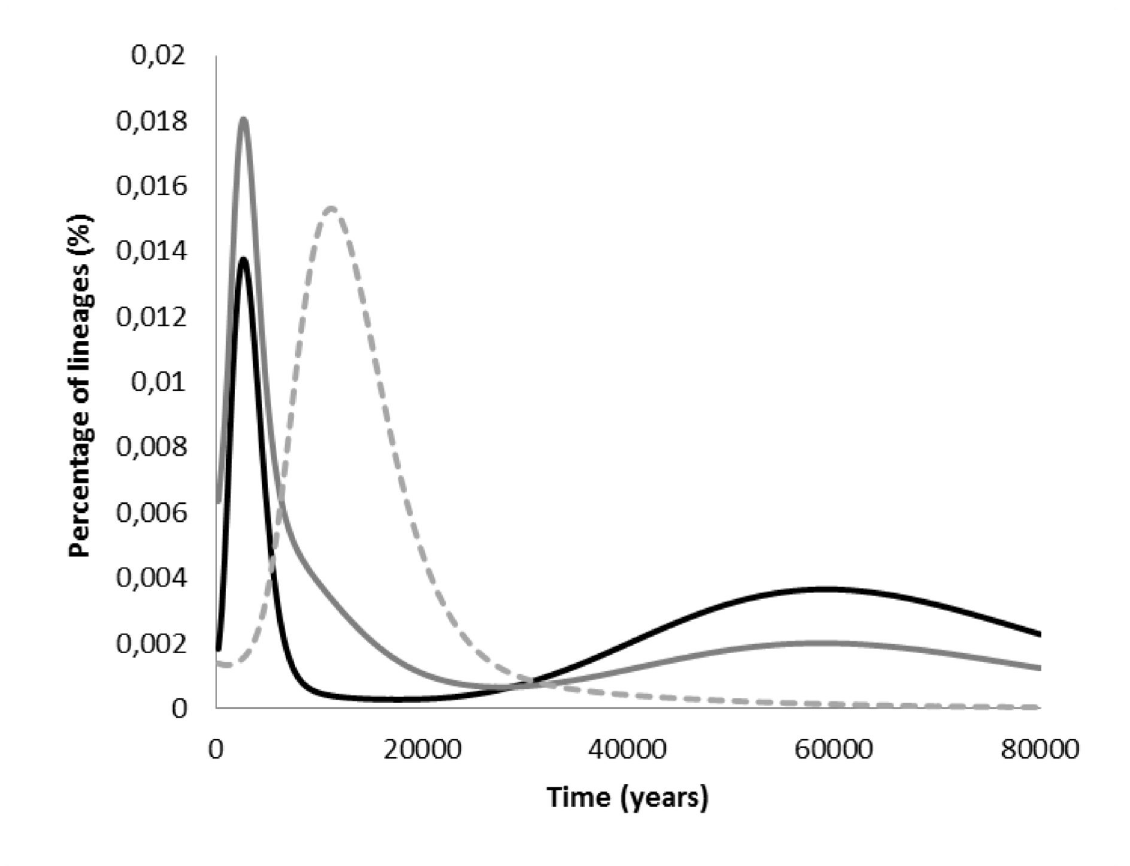
Figure 4. Probabilistic distribution of founder clusters across migration times scanned at 200 years intervals from 0–80 ka, using the f1 criterion, for southern African L0 sequences (black filled line), for overall southern African mtDNA variation (grey filled line) and for L0 central African sequences considering an eastern African source (dashed line in